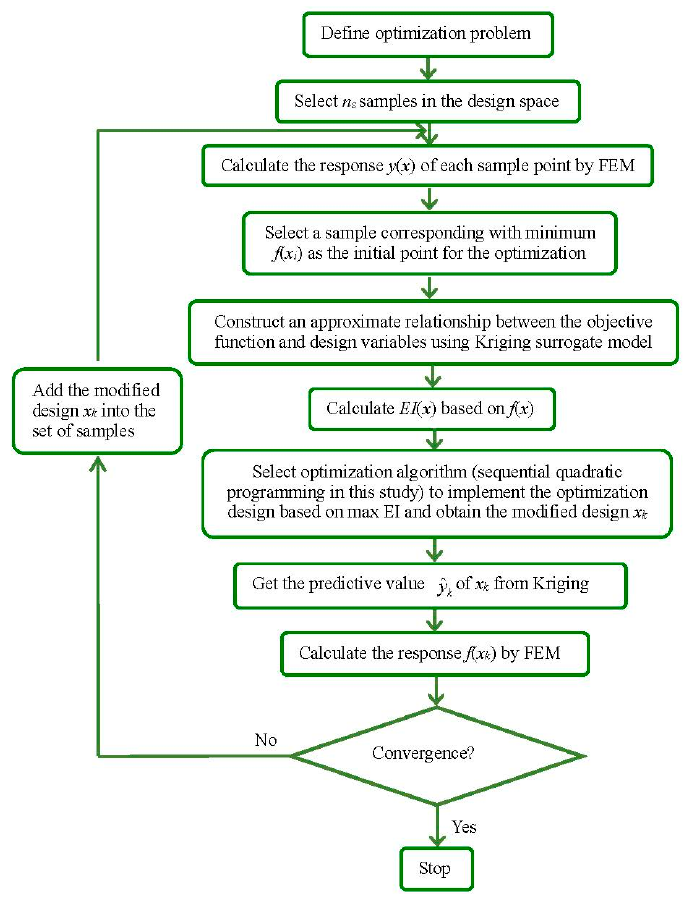
Figure 7. Flowchart showing the process of optimization algorithm based on surrogate model.